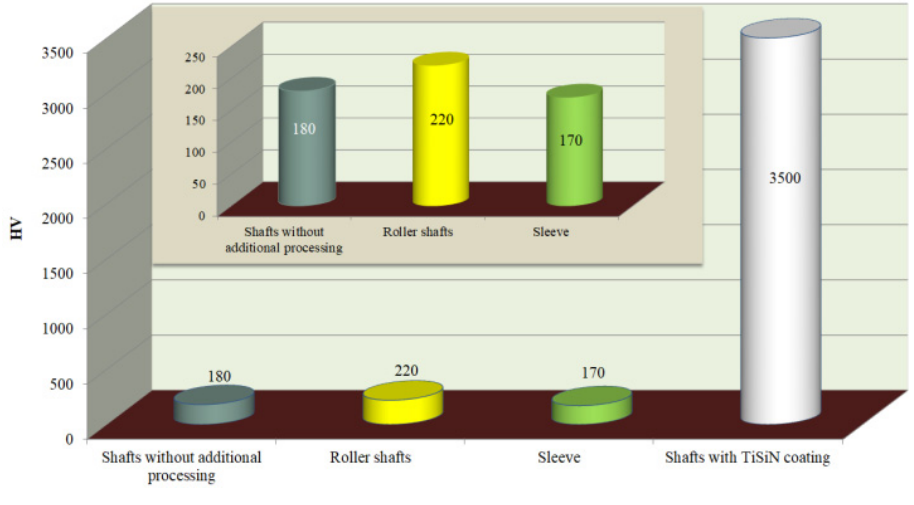
Figure 3. Shaft surface hardness.